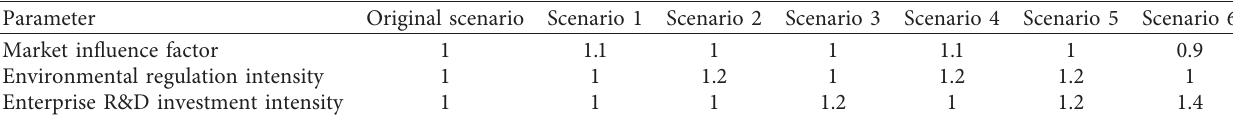
2 emission. (b) Industrial output value of coal enterprises. (c) Energy consumption per Table 2: Scenario analysis parameter setting table.